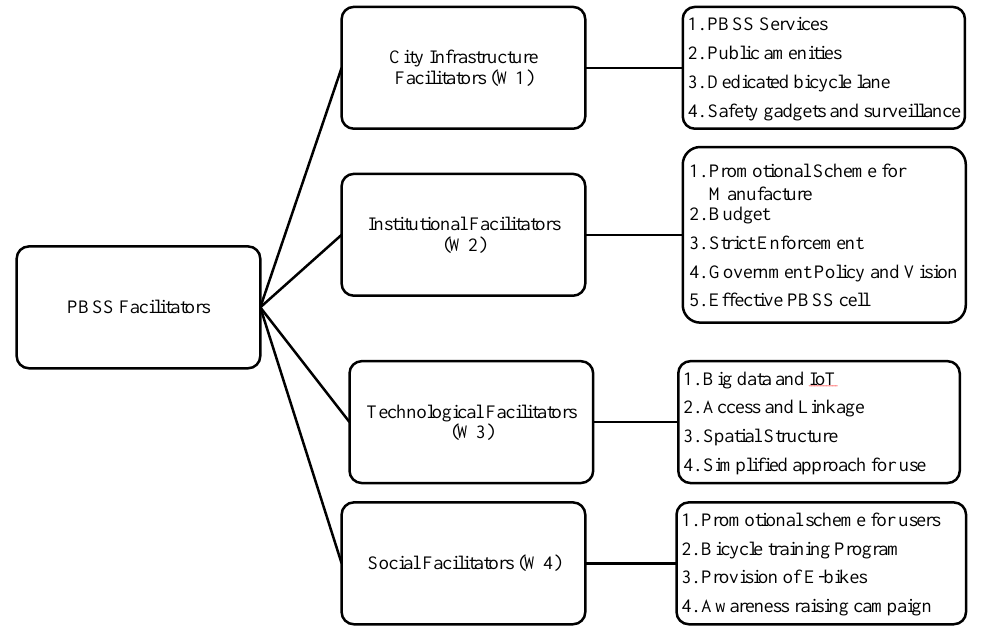
Figure 1. Hierarchical structure of PBSS facilitators